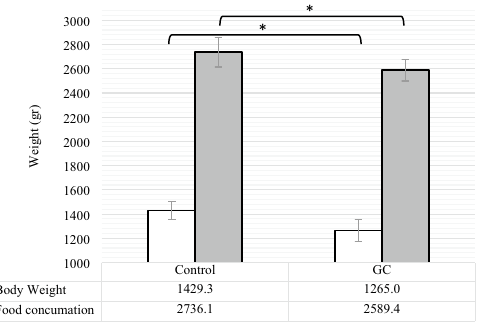
Figure 5. The comparison of body weight and food consummation between control and GC (Fluticasone, 2 ppm). Different statistical marks are significant (*P ≤ 0.05, **P ≤ 0.01, and ***P ≤ 0.001) according to the Dunnett’s test as a comparison procedure.